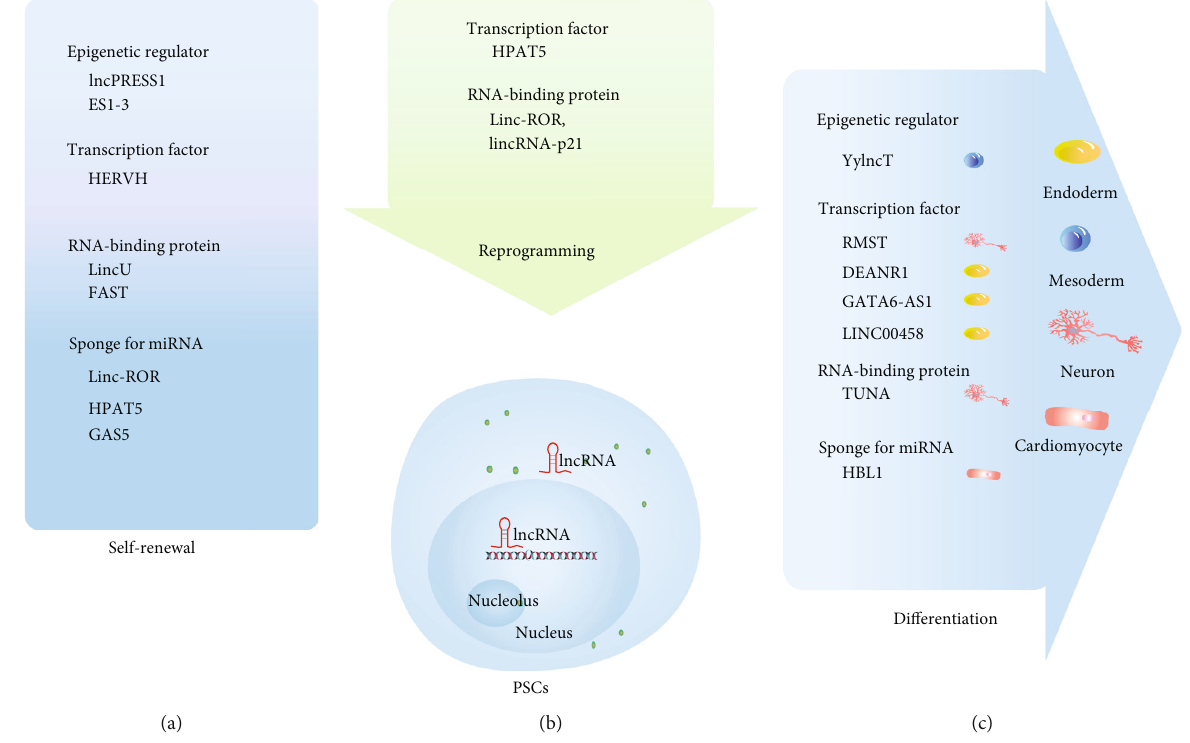
Figure 3: Mechanisms of lncRNAs in pluripotency, di ff erentiation, and reprogramming of PSCs by interacting with di ff erent partners. Epigenetic regulator: recruit chromatin modi fi cation factors to a ff ect chromatin status; transcription factor: binding transcription factors to regulate gene transcriptional activity; RNA-binding protein: interacting with RNA-binding protein to directly regulate protein activity; sponge for miRNA: functioning as the sponge of endogenous miRNA, preventing miRNA targets from